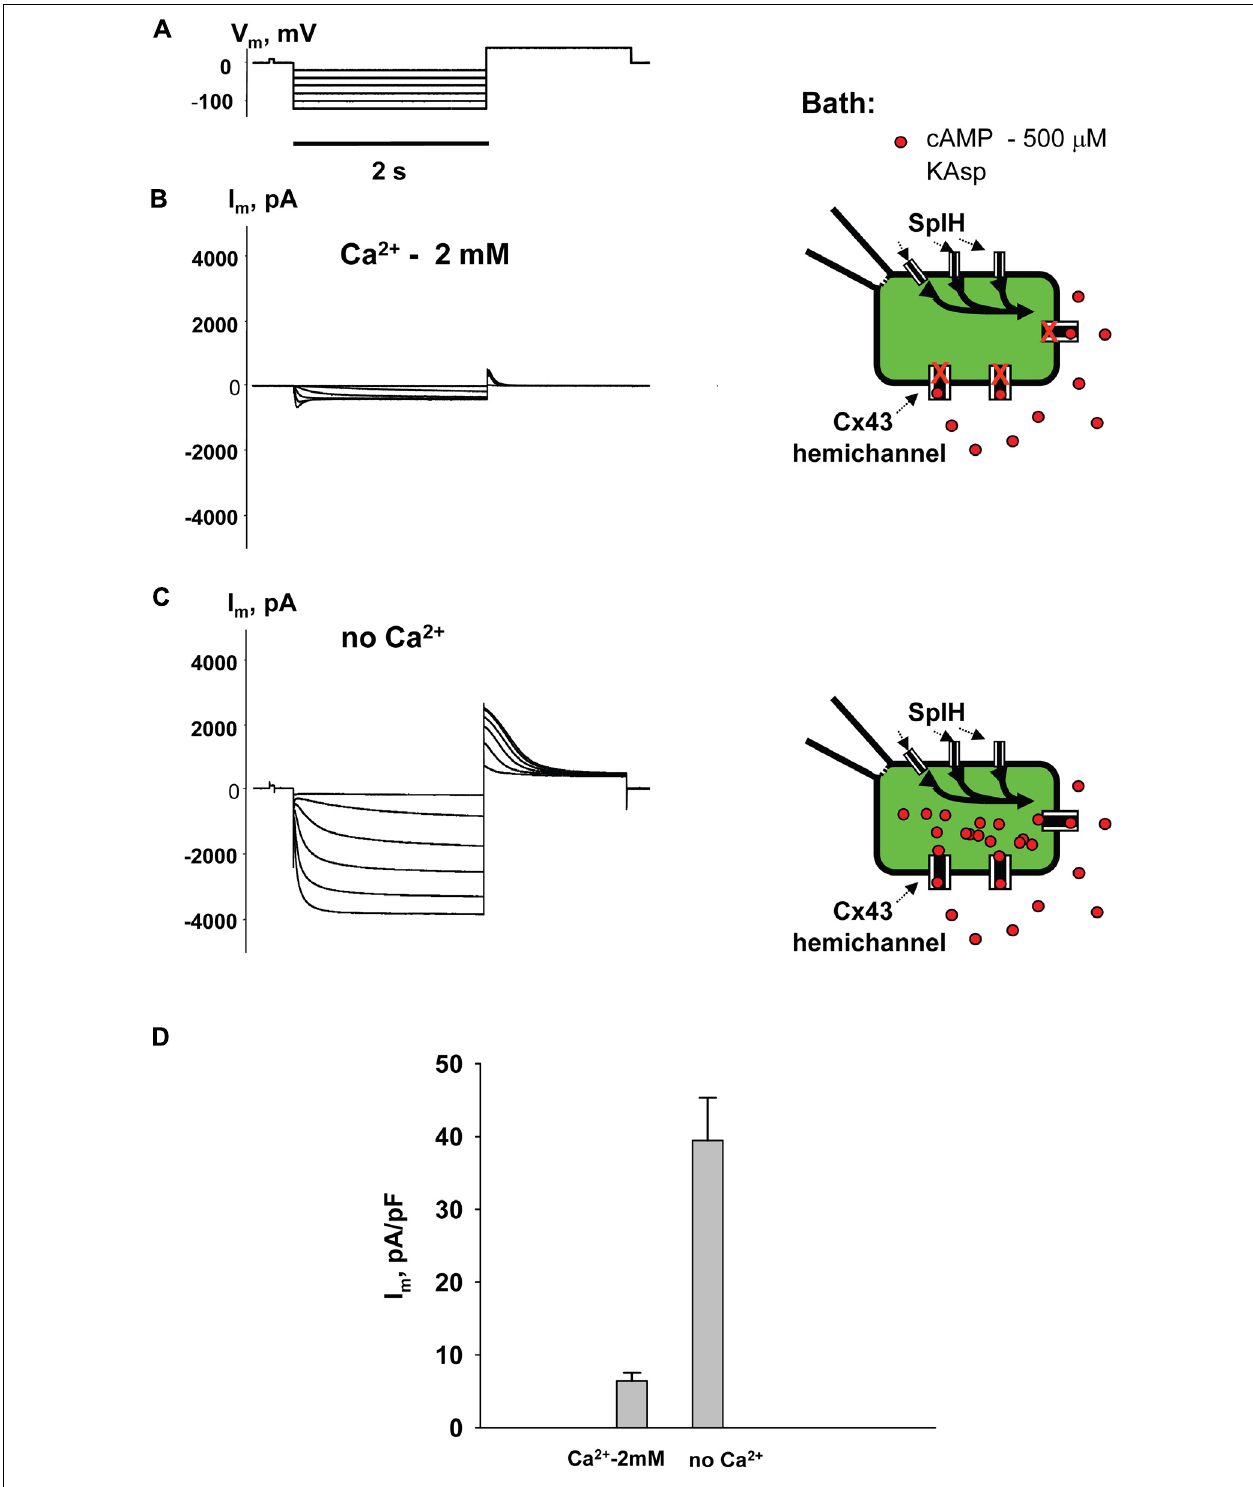
cAMP. I m increased significantly with V m and hyperpolarization induced voltage- and time-dependent inward currents when no external Ca 2 + was present. (D) Average of current amplitudes recorded in the presence and in the absence of external Ca 2 + , respectively: 6.4 ± 1.1 pA/pF, n = 10 versus 39.5 ± 5.8 pA/pF, n = 13; P <